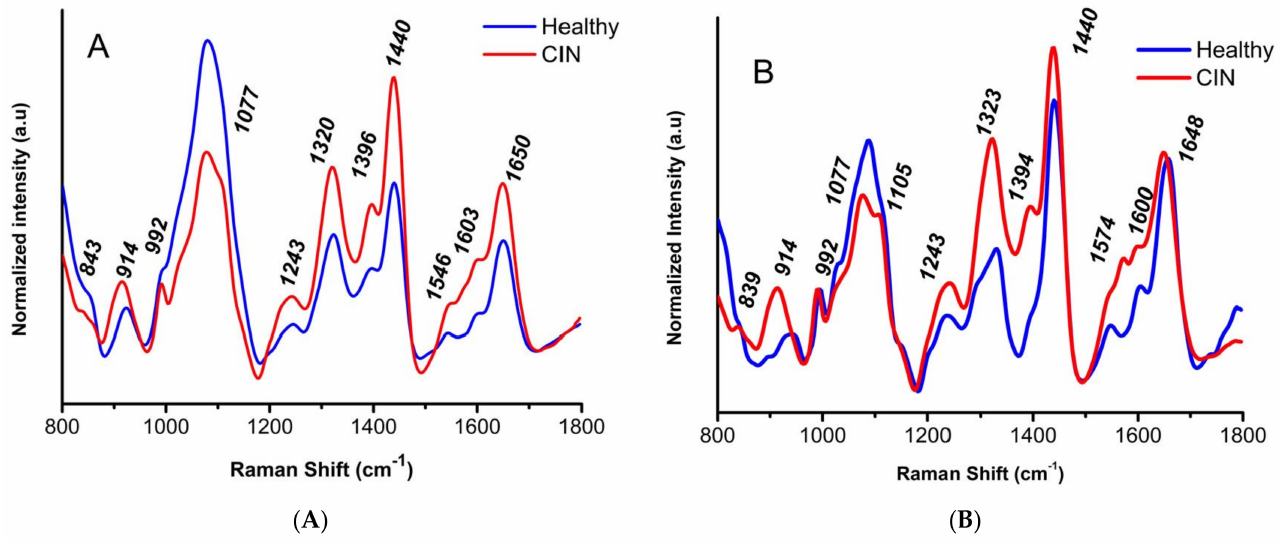
Figure 1. Raman spectra of exfoliated cervical cells from healthy and CIN patients. ( A ) Average spectrum obtained from the cervical cell cytoplasm of healthy patients (blue line) and that of patients with a cervical lesion, CIN (red line). ( B ) Average of Raman spectra of the cervical cell nucleus of a healthy patient (blue line) and a patient with lesion, CIN (red line). The most prominent bands are shown for both cytoplasm and nucleus